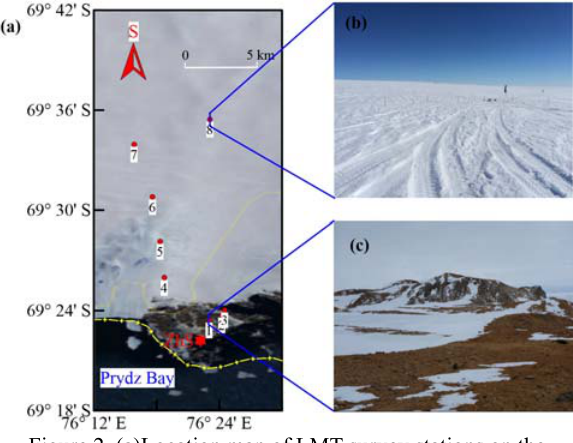
Figure 2. (a)Location map of LMT survey stations on the Antarctic continent, with the location of Zhongshan Station marked in red hexagon, and the red solid point as the survey point; (b)Landform photo of the 8th LMT station; (c)Landform photo of the 1th LMT